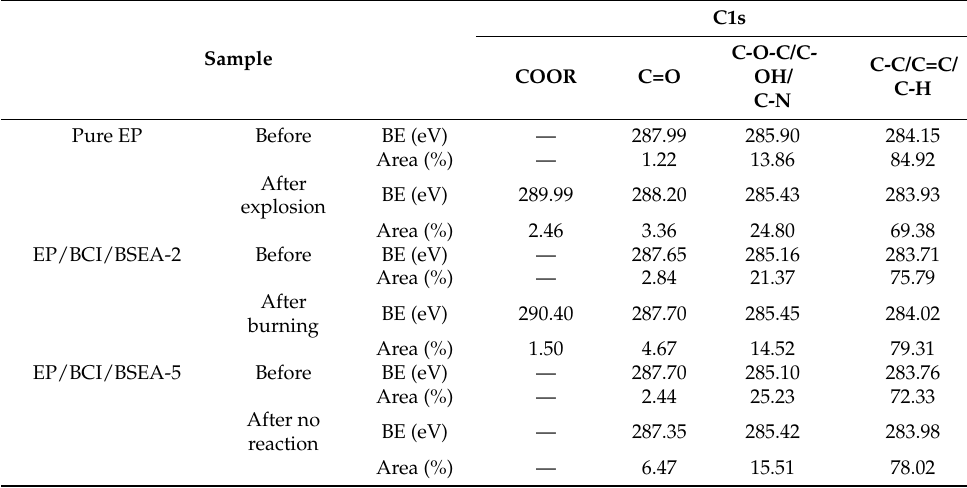
Figure 4. C1s spectra of pure EP ( a ) before and ( a1 ) after, EP/BCI/BSEA-2 ( b ) before and ( b1 ) after, EP/BCI/BSEA-5 ( c ) before and ( c1 ) after the liquid oxygen compatibility test. Table 3. C1s peak fitting results of pure EP and BSEA-modified EP.